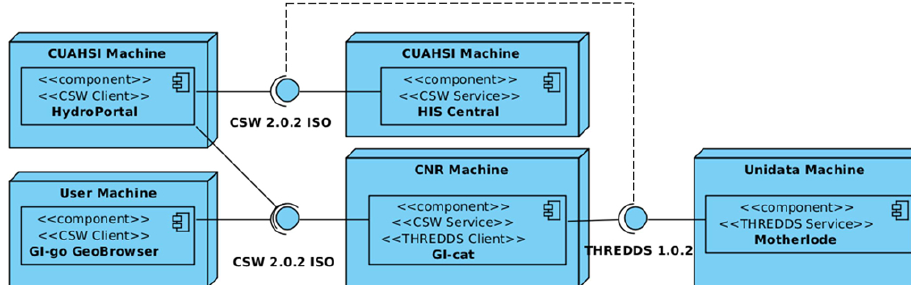
Fig. 14. GI-cat experimental deployment diagram.